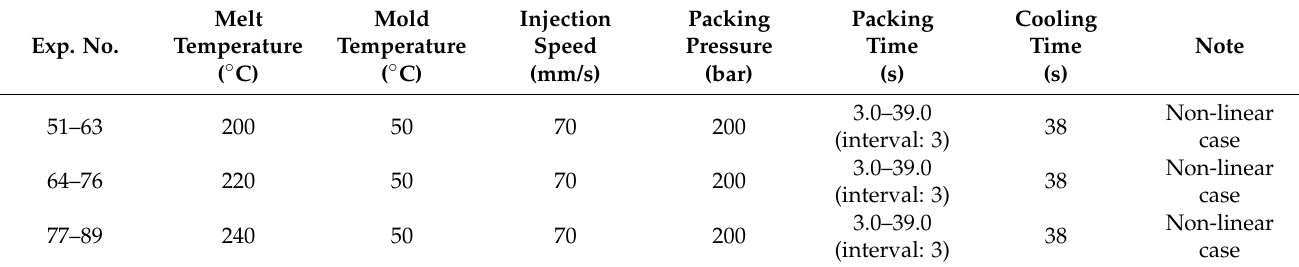
Table 6. Injection molding conditions of nonlinear relation group.